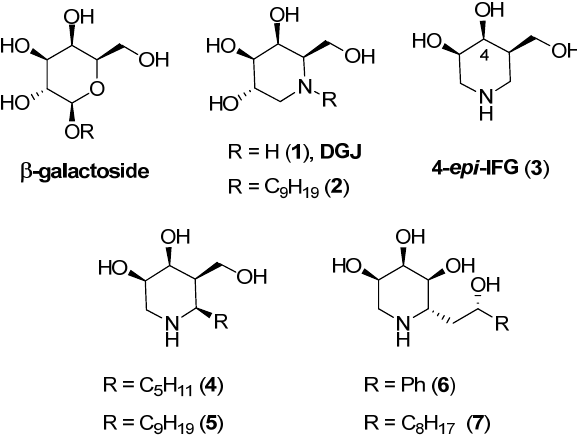
Figure 1. S tructures of a general β -galactoside and of some imino- and azasugars inhibitors of β -Gal.